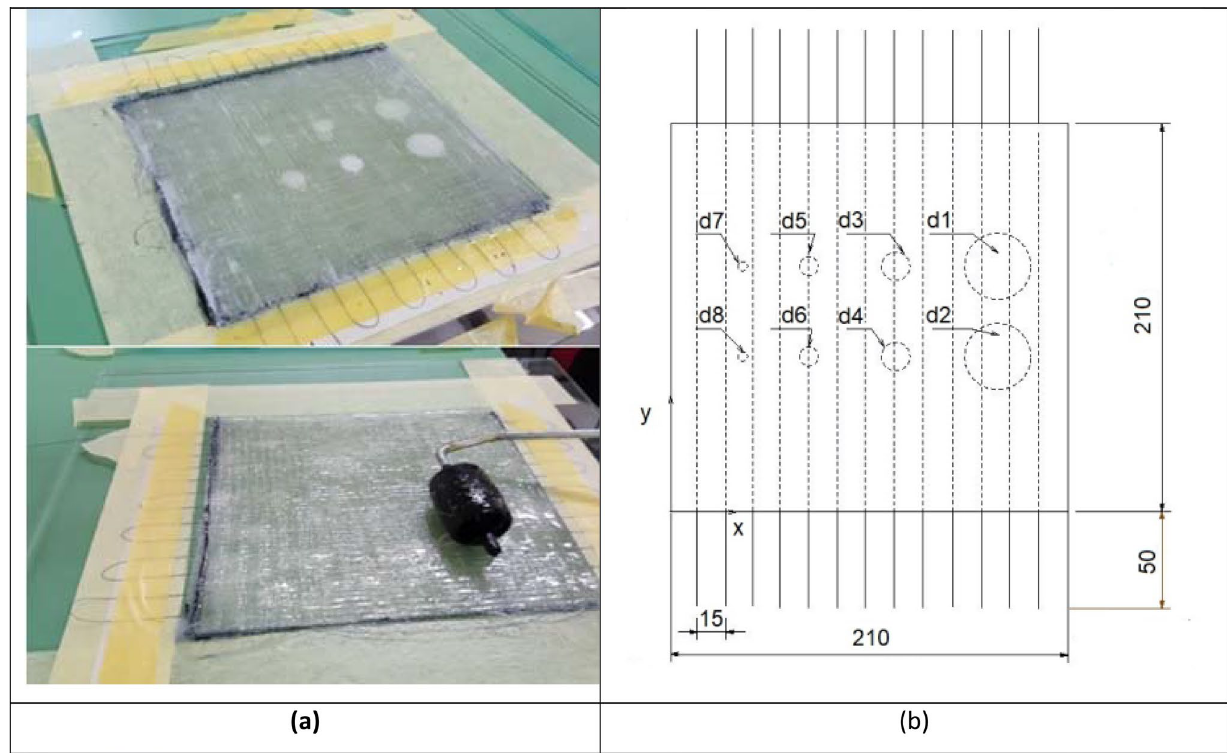
Fig. 2 Realization of panel with embedded SMA wires and defects: a details during manufacturing phases; b geometry and localization of